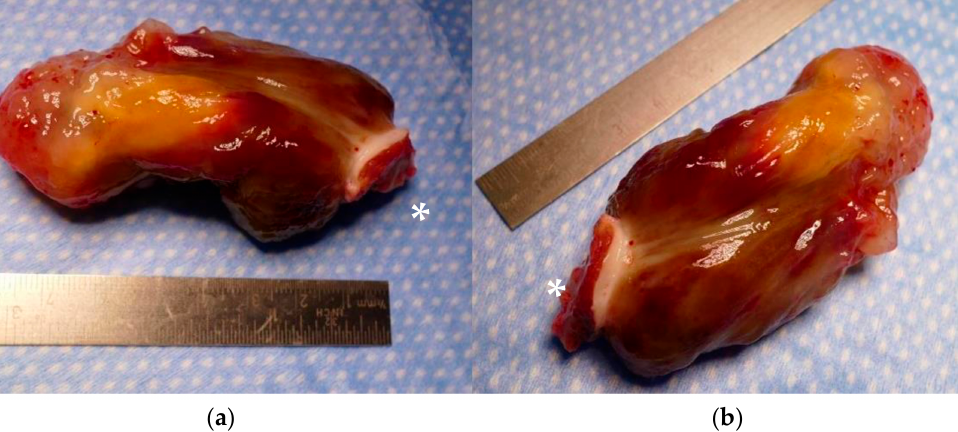
Figure 3. Proportion of c oncomitant procedures in patients with myxoma. MKR: mitral valve reconstructions, and MKE: mitral valve replacement and ACVB: coronary artery bypass graft).